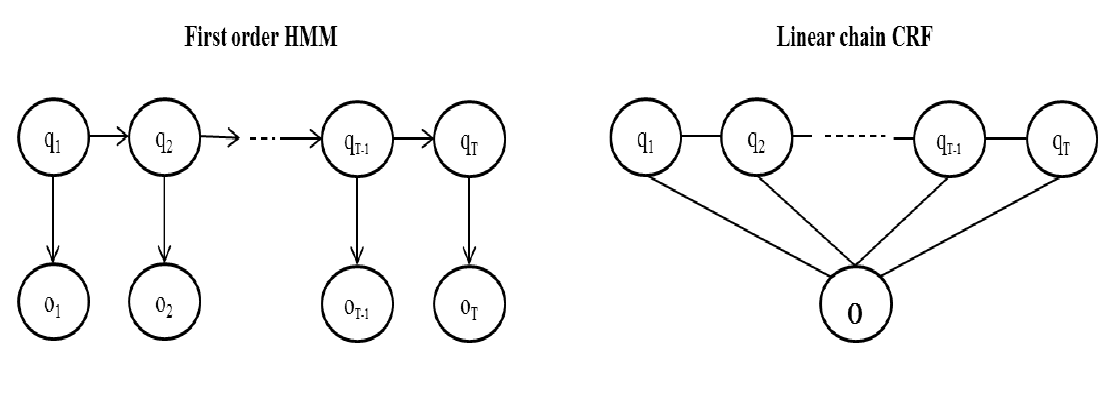
Figure 1. A visual comparison between a first order HMM and a linear chain CRF. The HMM defines a joint probability P ( O , Q ) whereas the CRF defines a conditional probability P ( Q | O ) . Note that an HMM only has access to the current observation o access to the entire observation sequence O at any given